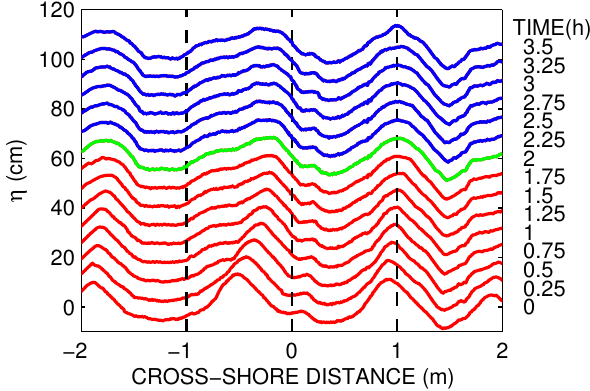
Figure 9. Ripple profile time stack during the first tide on YD132. Red indicates rising tide, green high tide, blue ebb. Cross-shore dis- tance is positive o ff shore.